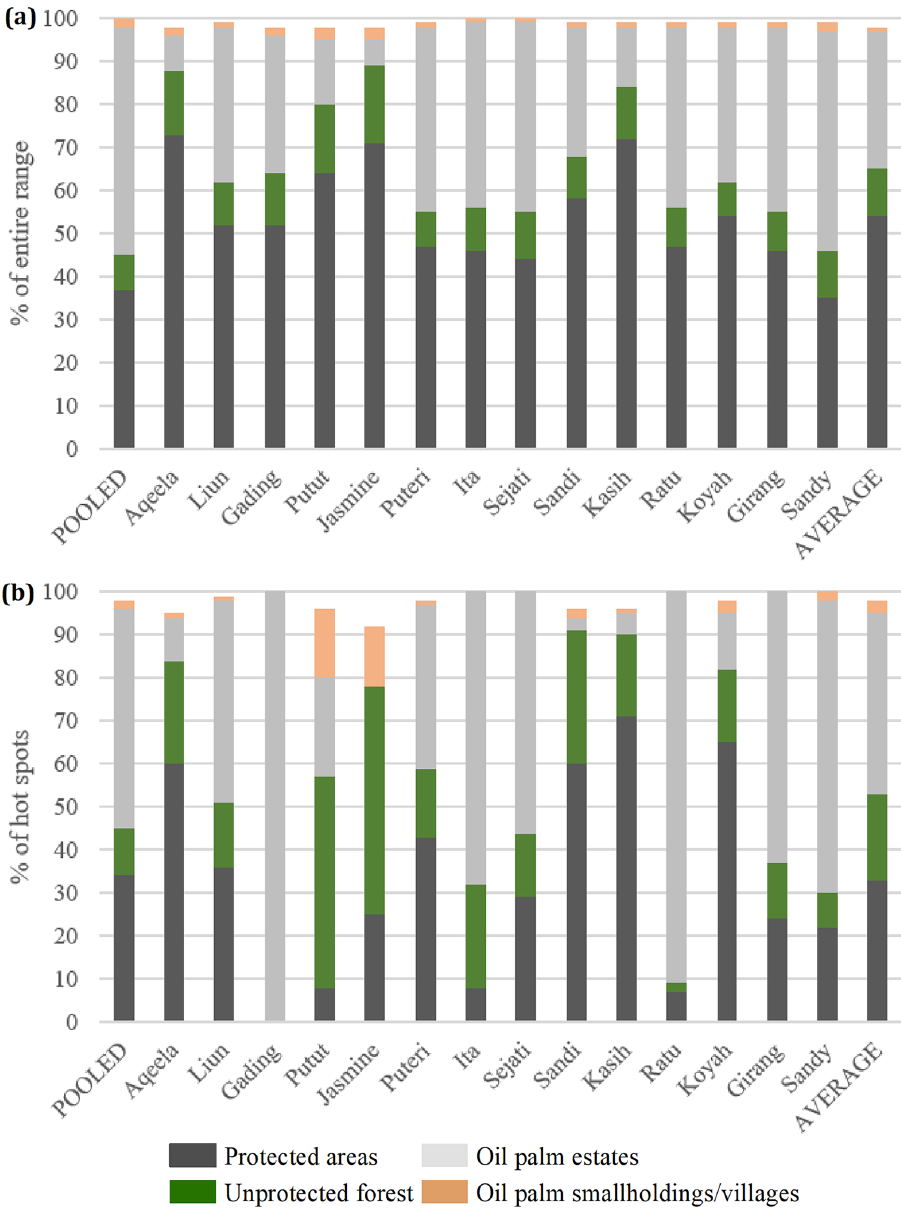
Figure 3. Proportions (%) of protected areas, areas of unprotected forest, areas of oil palm estates, and areas of village lands and oil palm smallholdings, within elephants ( a ) entire range, and ( b ) hot spots, along with pooled and average